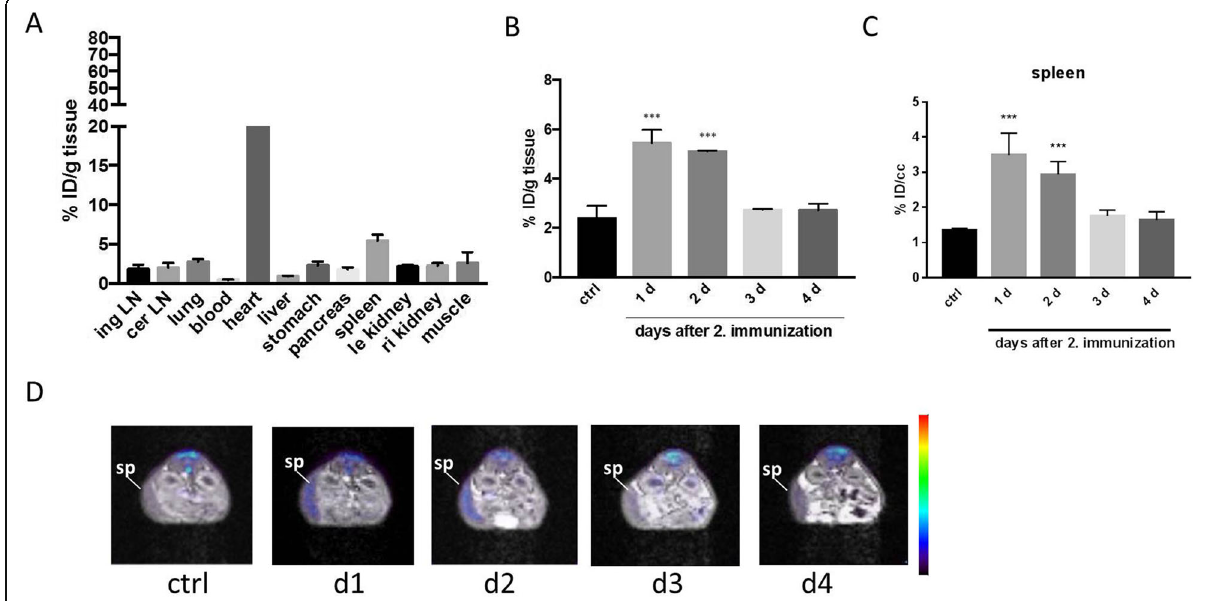
Fig. 1 Visualization and quantification of FDG uptake. a Ex vivo biodistribution 24 h after second RNA-lipoplex vaccination shows elevated FDG uptake predominantly within the spleen which is the organ with the second highest FDG uptake after myocardium. b , c Time course of elevated spleen metabolism after the second of two weekly RNA-lipoplex vaccinations FDG uptake returns to normal levels as early as after 72 h. Controls were injected with 0.9% saline. FDG uptake was quantified either by ex vivo biodistribution ( b ) or by in vivo PET imaging ( c ). d Visualization of time course of FDG uptake by axial PET/MR